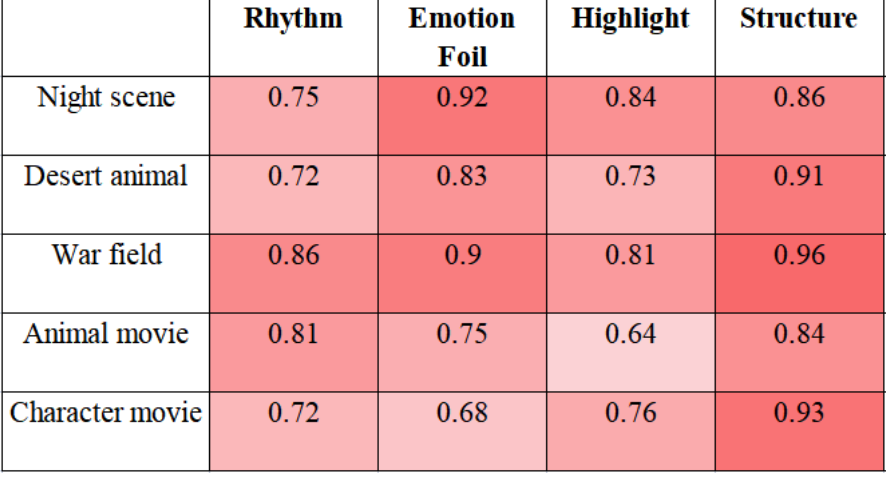
Figure 5. The Cronbach score of voting scores of the expert evaluation